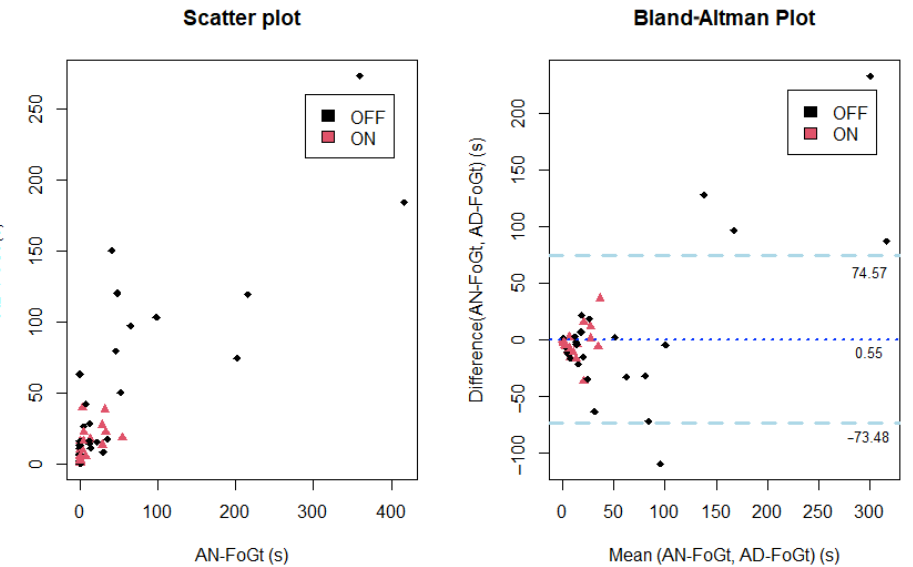
Figure 2. Scatter plot of the clinician’s annotated episodes (AN-FoGt) and algorithm detected FoG episodes’ duration (AD-FoGt) on the left side and Bland–Altman plot on the